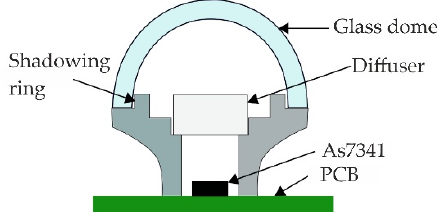
Figure 2. Schematic representation of the cross-section of the sensing part of the sensor node.